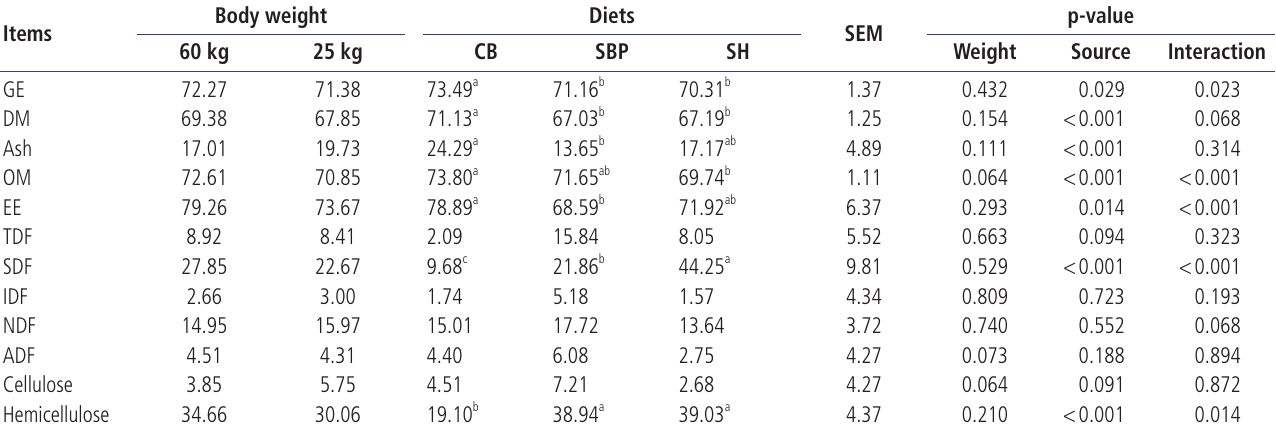
Table 4. Effects of pig body weight and fiber sources on the apparent ileal digestibility (%) of dietary nutrients 1)